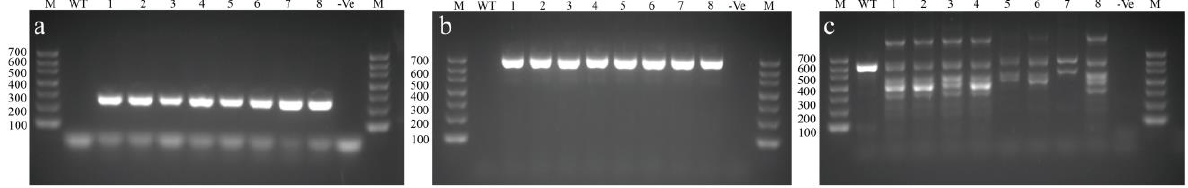
Figure 4. Different amplified StcU-2 -gene-edited Ascosphaera apis ( A. apis ) target gene bands. ( a ) Bands of wild-strain, eight stably selected Cas9-gene-edited StcU-2 mutants of A. apis , and negative control for EGFP gene integration. ( b ) Bands of wild-strain, eight stably selected Cas9-gene-edited StcU-2 mutants of A. apis , and negative control for hph gene integration. ( c ) Bands of wild-strain, eight stably selected Cas9-gene-edited StcU-2 mutants of A. apis , and negative control for StcU-2 gene being edited. For all: M denotes the DNA Marker 700 ladder; WT denotes A. apis wild strain.